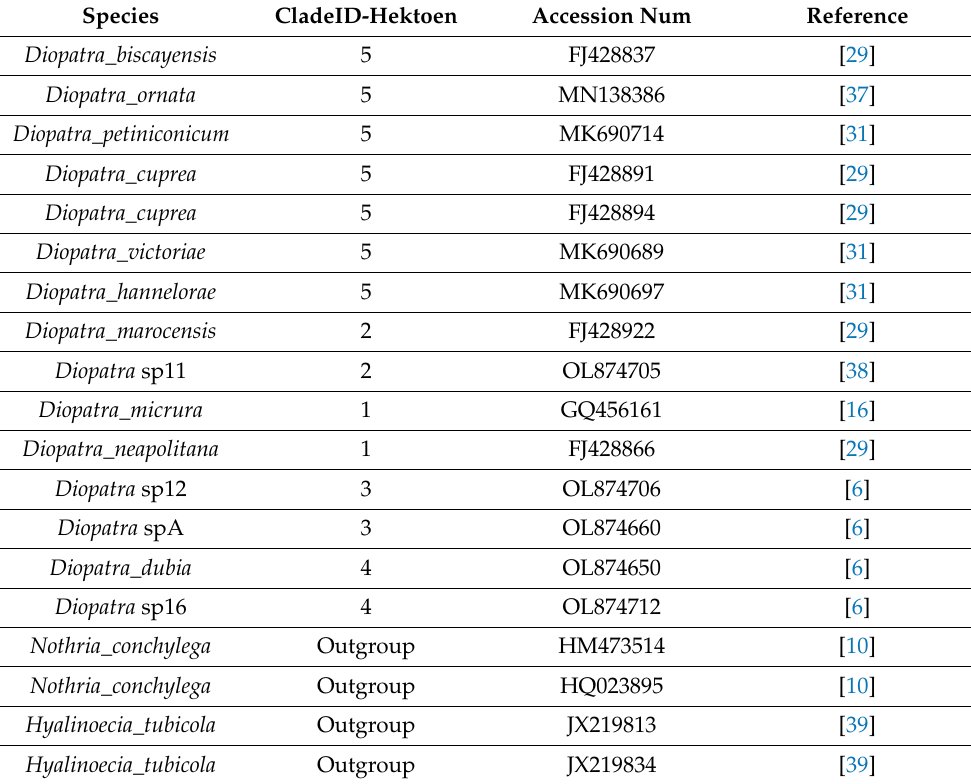
Table 2. GenBank accession numbers of COI for Diopatra spp. and other polycheates.